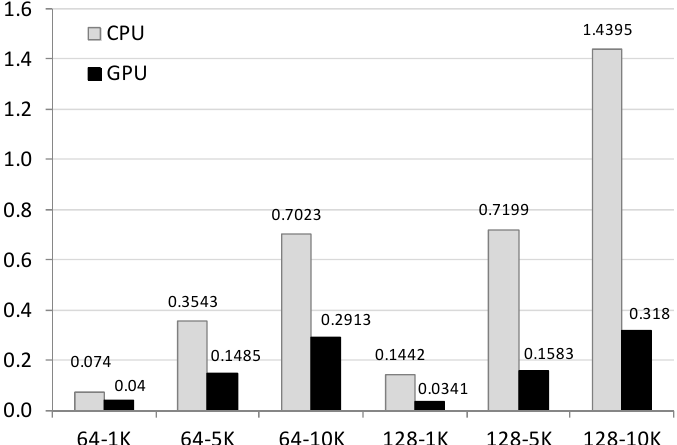
Figure 9. CPU and GPU times (in ms) for Att48 with respect to different populations (64 and 128) and iterations (1000, 5000, and 10,000).